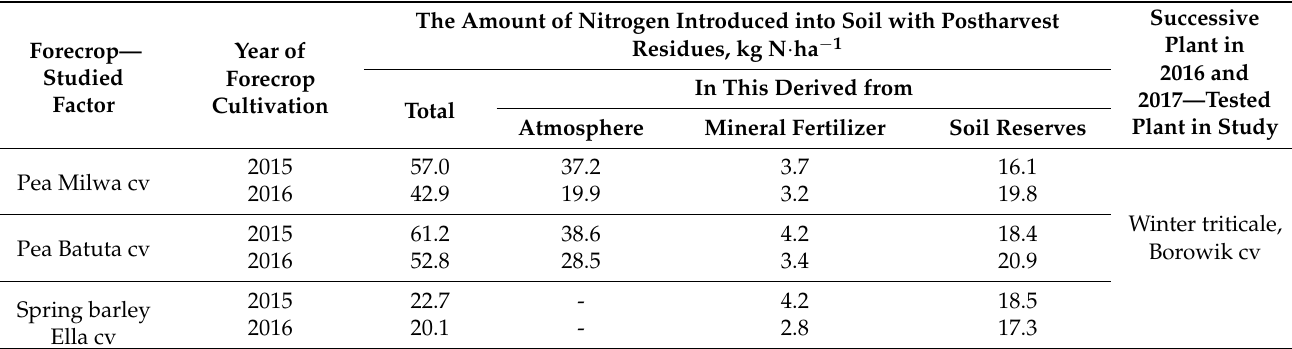
Spring barley Ella